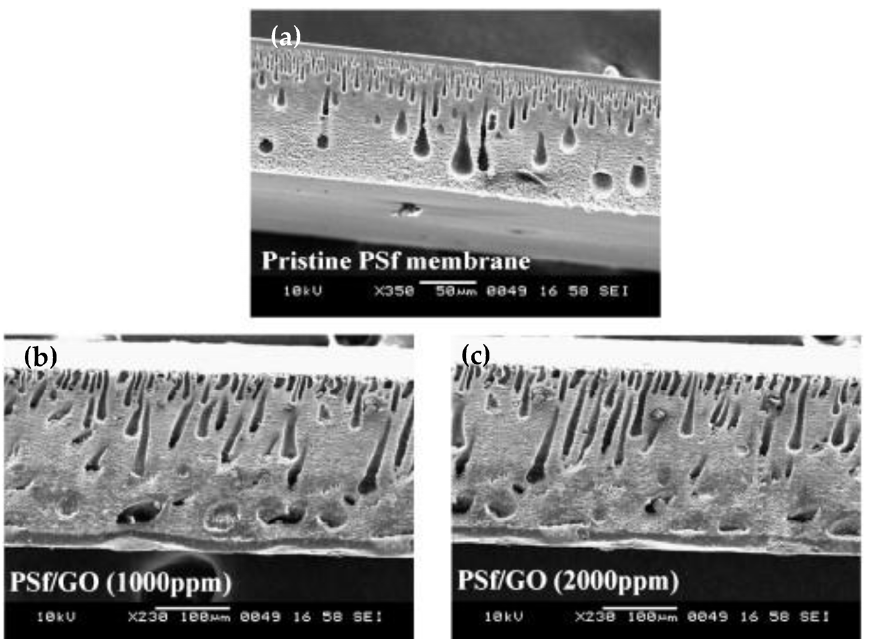
Figure 8. Cross sectional SEM illustration of ( a ) pristine PSf, ( b ) 1000 ppm GO loaded PSf, ( c ) 2000 ppm GO loaded PSf. Adapted with permission from Ganesh et al. [232]. Copyright (2013) Elsevier.